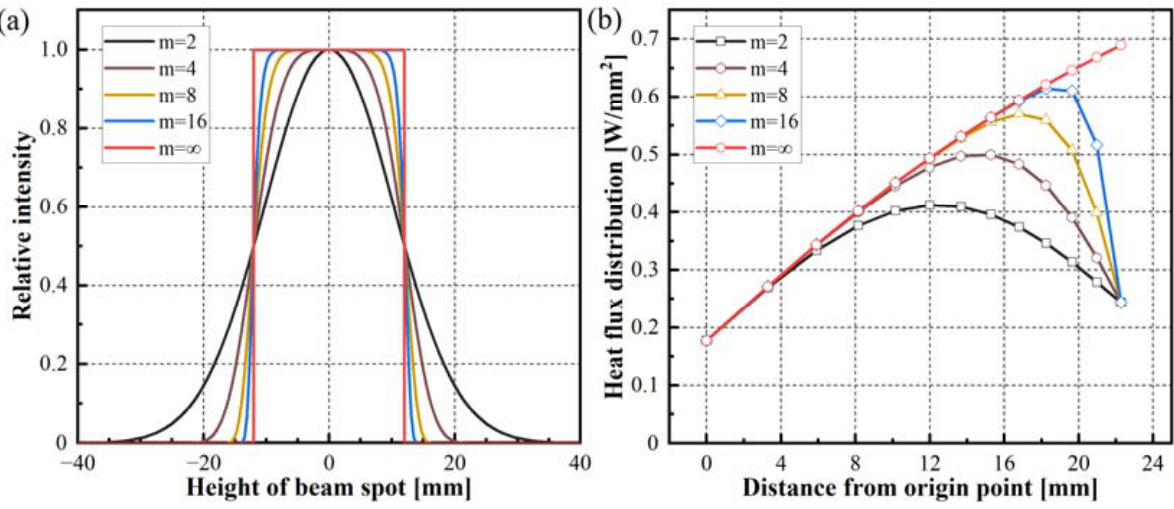
Figure 13. Intensity normalized distribution of the Super-Gaussian profile beam ( a ) and effect on the surface heat flux distribution on the curved tape ( b ).